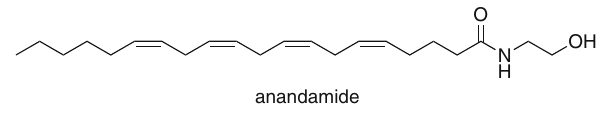
Fig. 1 The structure of